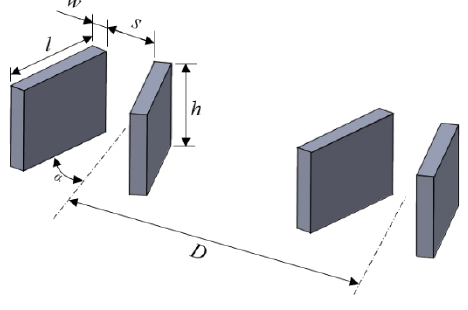
Figure 2. Configuration of VGs. Table 1. Geometrical parameters for VGs.